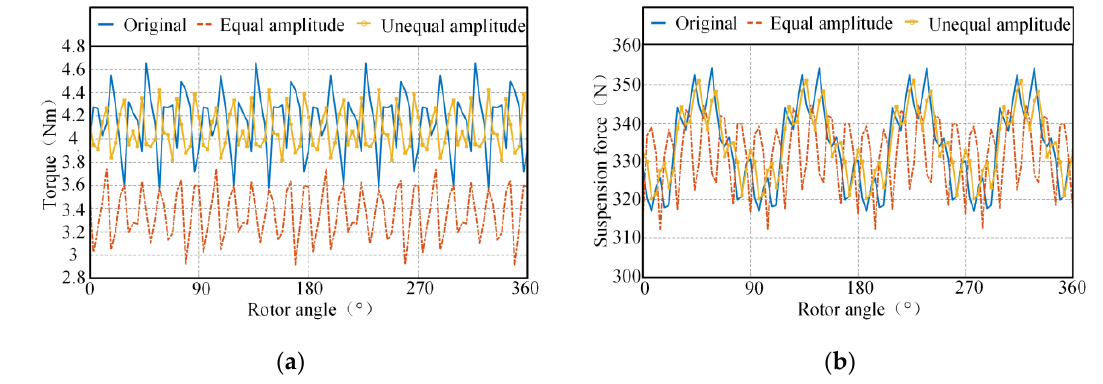
Figure 8. Load Results. ( a ) Torque; ( b ) Suspension